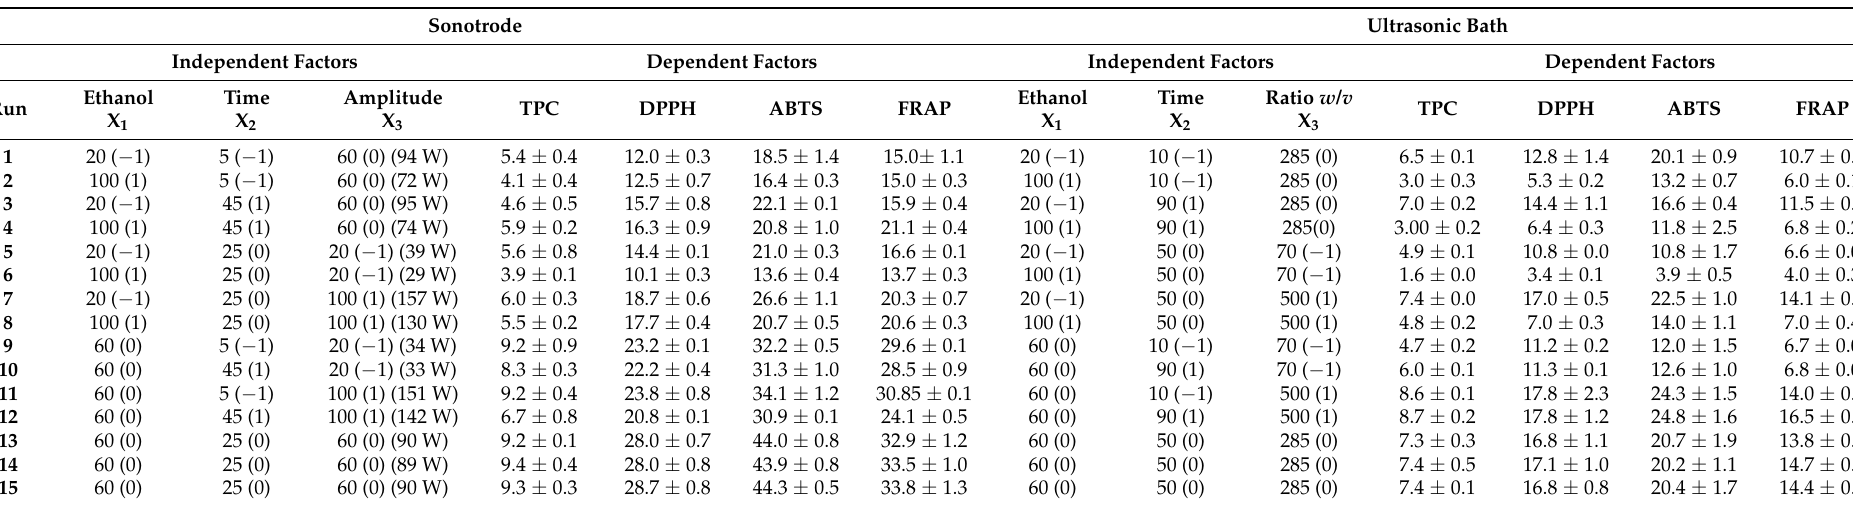
Table 1. Box–Behnken design with natural and coded values (parenthesis) of the conditions of sonotrode and ultrasonic bath extraction and the experimental results obtained for total phenolic compounds (TPC), and antioxidant assays (DPPH, ABTS, and FRAP) expressed with the average and the standard deviation.